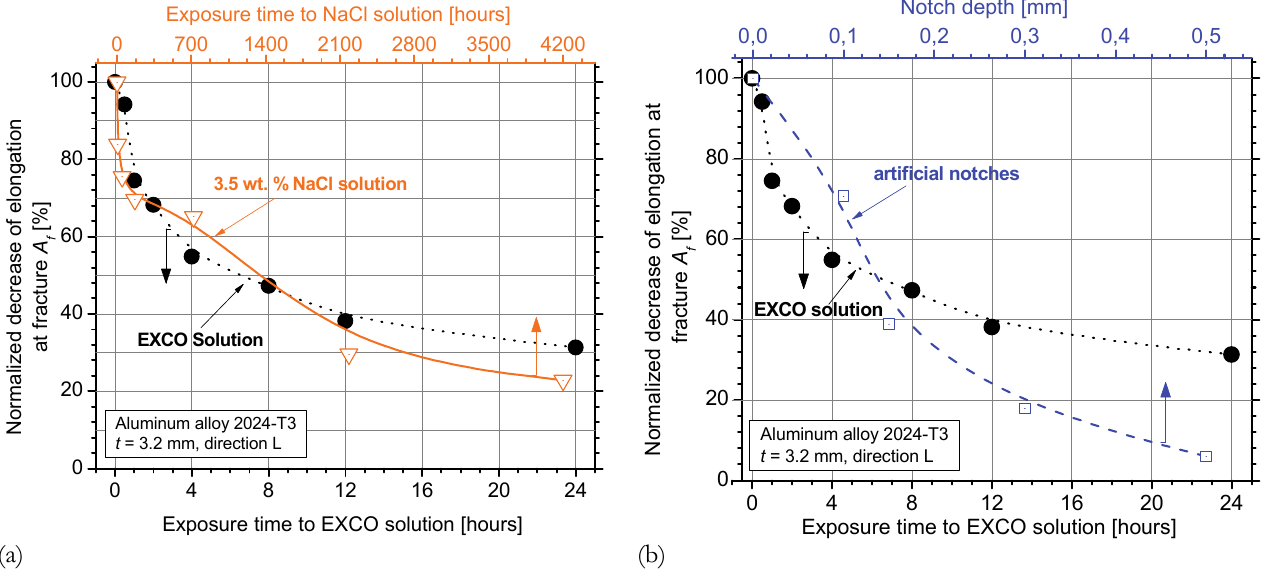
Figure 6: Normalized decrease of elongation at fracture A f values for the various exposure times to the EXCO solution of AA2024-T3 compared with (a) 3.5 wt. % NaCl solution and (b) notch